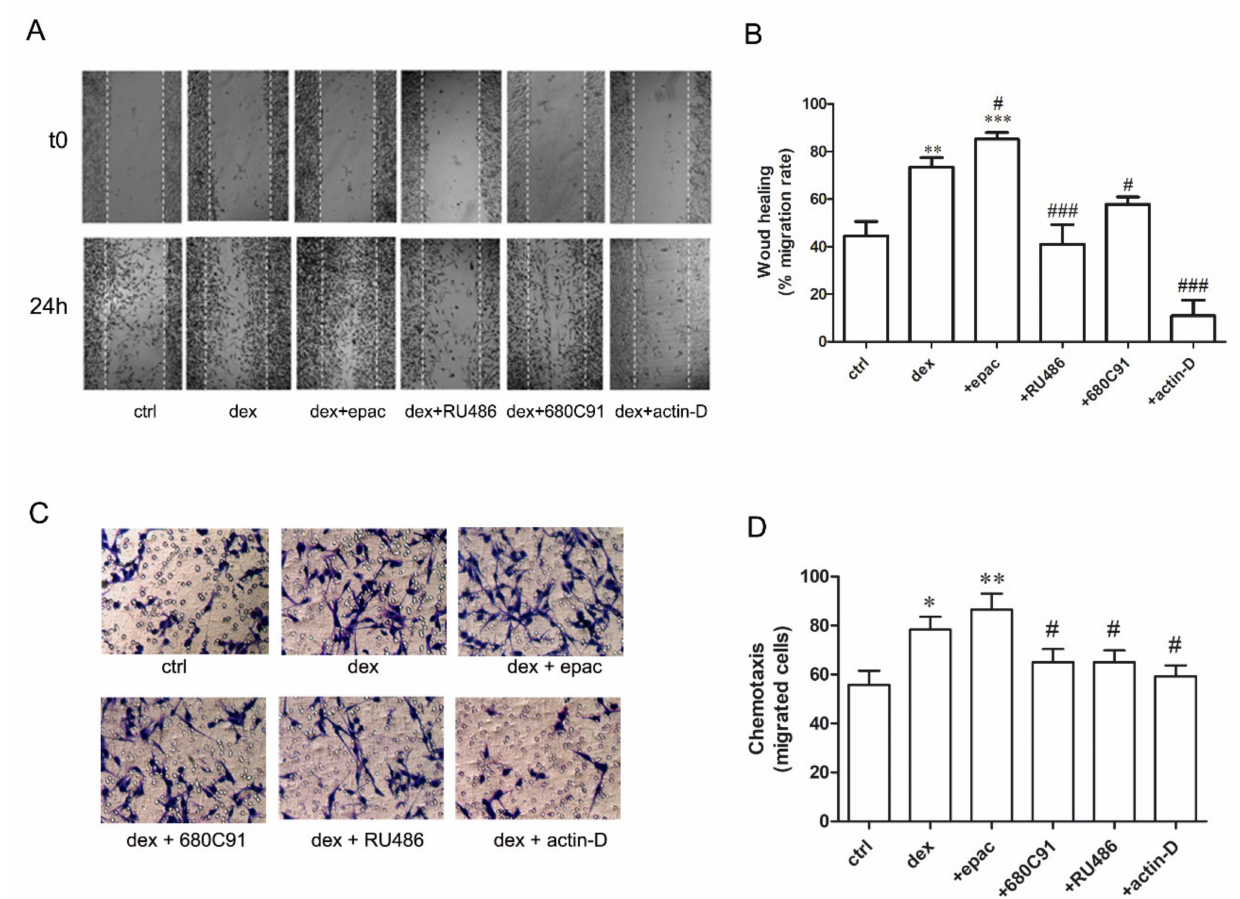
Figure 7. Dex stimulates SK-Mel-28 cell migration. ( A , B ) Scratched monolayer was treated with 25 µ M dex for 24 h in absence (dex) or in presence of RU486 (1 µ M), 680C91 (40 µ M), epacadostat (1 µ M), or actinomycin-D (10 Nm). ( A ) Photomicrographs of the wound were taken, and representative images are shown (4 × ). ( B ) Quantitative measure of the wound’s width. Data represent mean ± SEM of the migration rate ( n = 5; ** p < 0.01, *** p < 0.001 vs. control unstimulated cells (ctrl); # p < 0.05, ### p < 0.001 vs. dex alone. ( C , D ) Chemotaxis of SK-Mel-28 cells stimulated with 25 µ M dex for 24 h in absence (dex) or in presence of RU486 (1 µ M), 680C91 (40 µ M), epacadostat (1 µ M) or actinomycin-D (10 nM). ( C ) Photomicrographs of the migrated cells were taken, and representative images are shown (20 × ). ( B ) Quantitative measure of cell chemotaxis. Data represent mean ± SEM of migrated cells ( n = 4; * p < 0.05, ** p < 0.01 vs. control unstimulated cells (ctrl); # p < 0.05 vs. dex